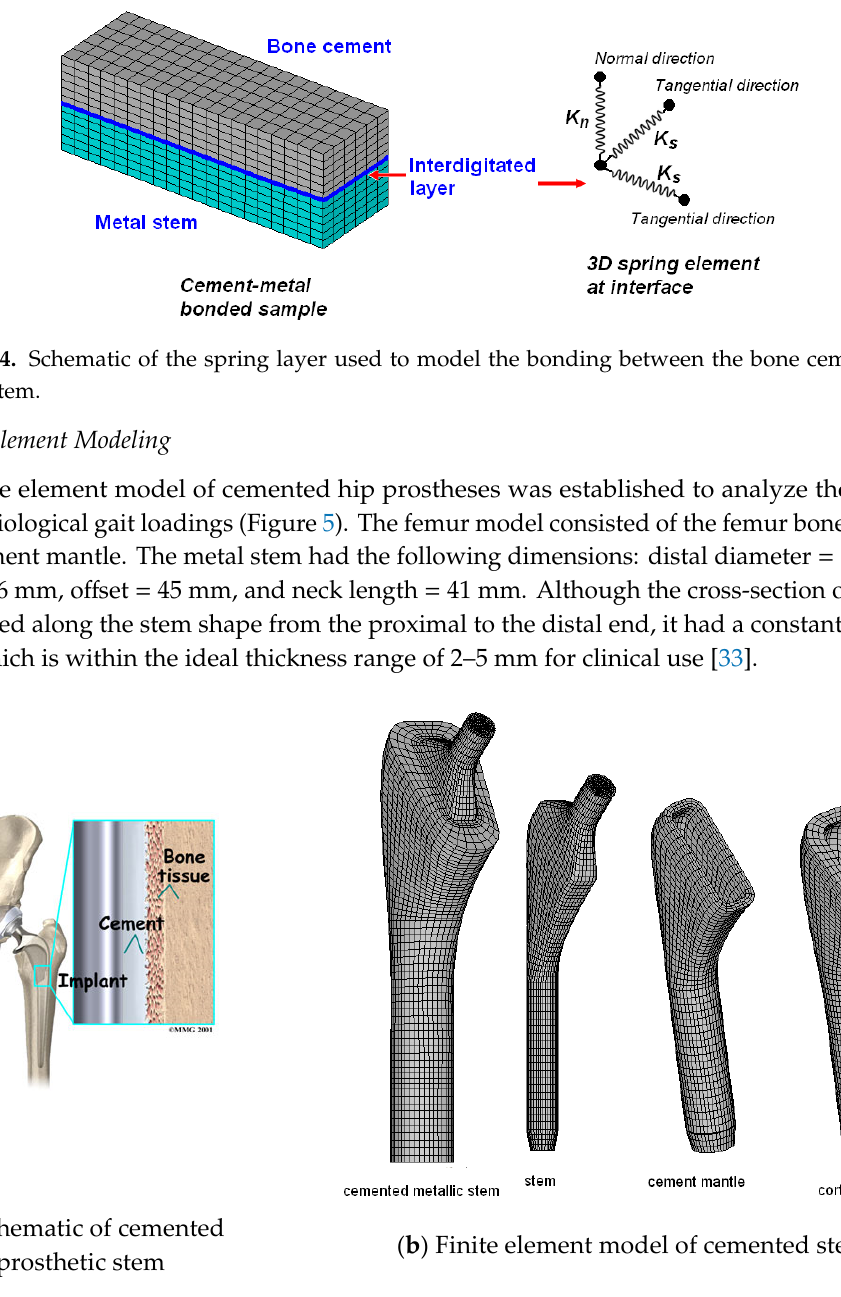
Figure 5. ( a ) schematic of cemented prosthetic stem [34]; ( b ) finite element model of the cemented femoral components, including stem, cement layer and femoral cortical bone.